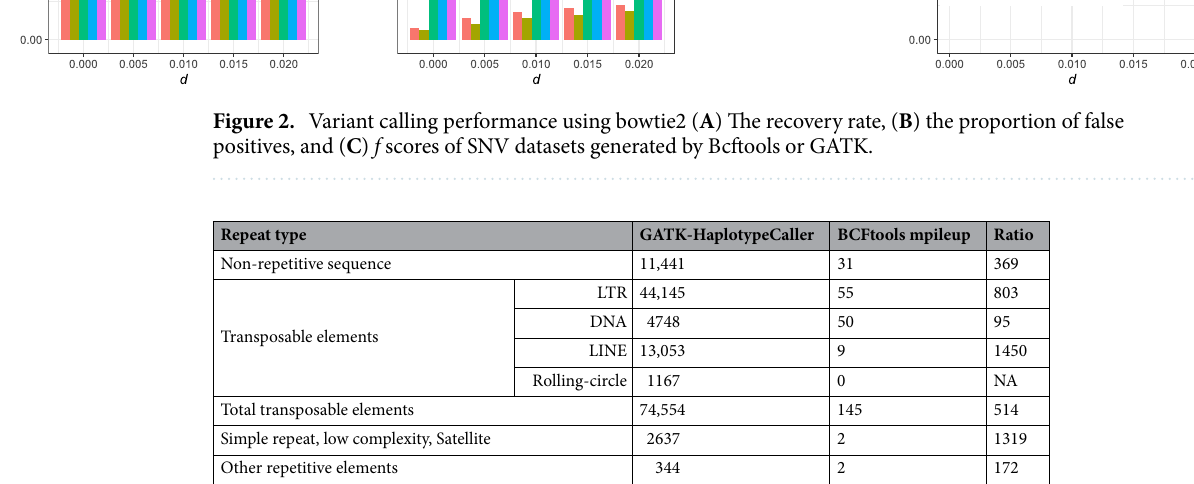
Table 2. The numbers of false positives according to different repeats generated by GATK HaplotypeCaller and Bcf mpileup, and the ratio of false positives from GATK HaplotypeCaller to Bcf mpileup.